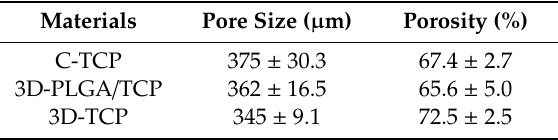
Table 3. Pore size and porosity.